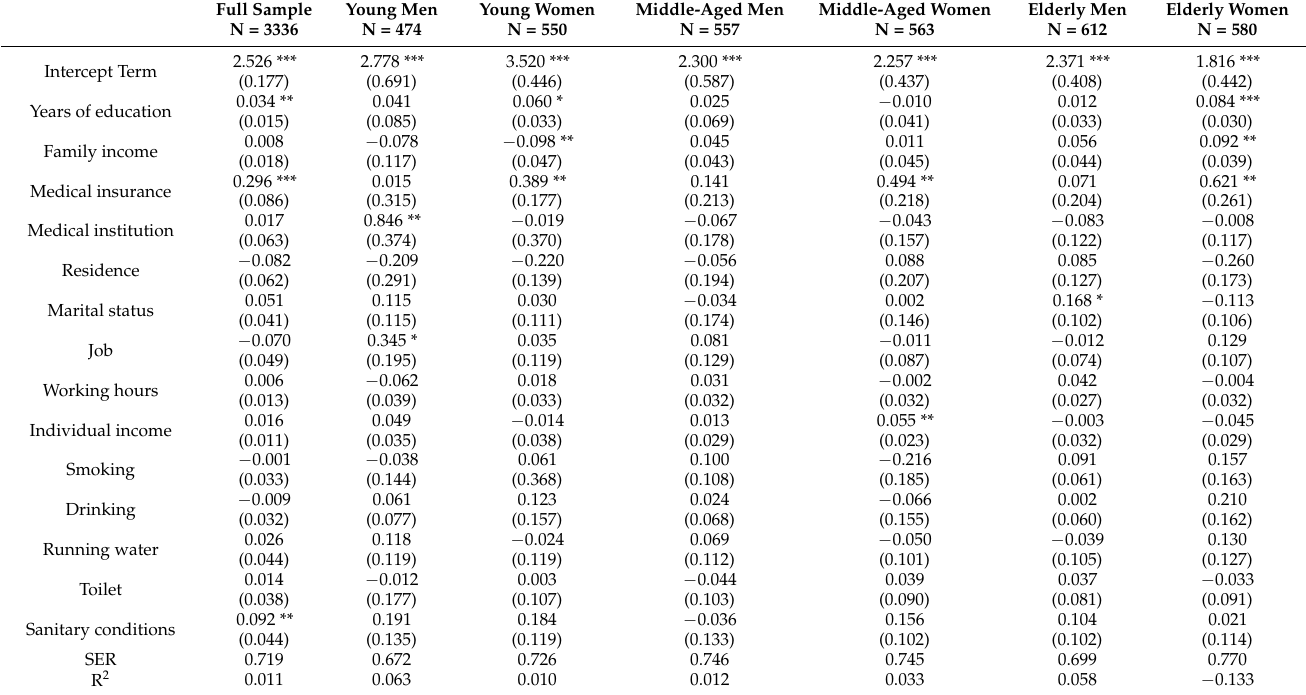
Table A8. Results of two-stage least squares (by age and sex, for psychological health).